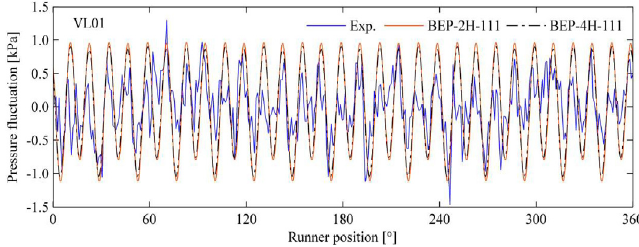
Fig. 3. Instantaneous pressure variation in the vaneless space at the BEP, Buron [11].